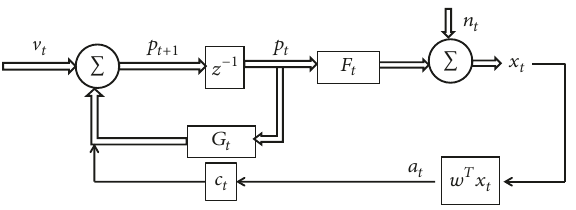
Figure 2: A state-space model to represent evaluation of the user preferences without feedback effects. Figure 3: A complete state-space model of the system with action generation and feedback